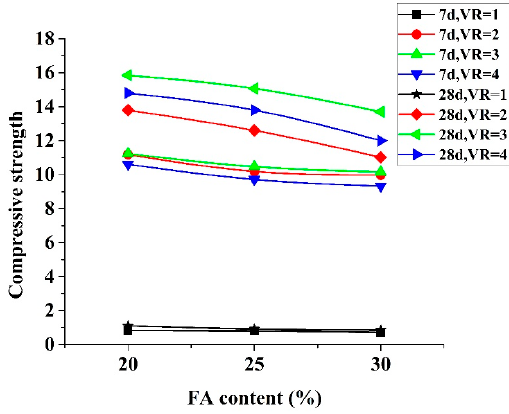
Figure 9. Test result of compressive strength of the specimen (VR: the volume ratio).